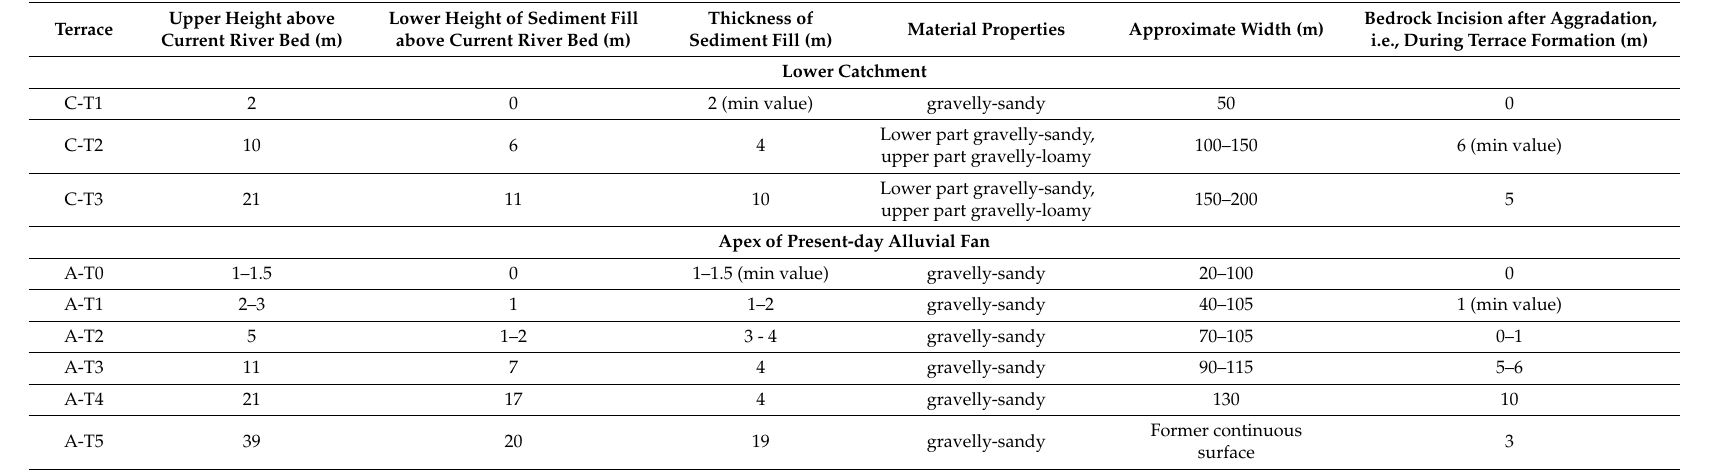
Table 2. Table of terrace